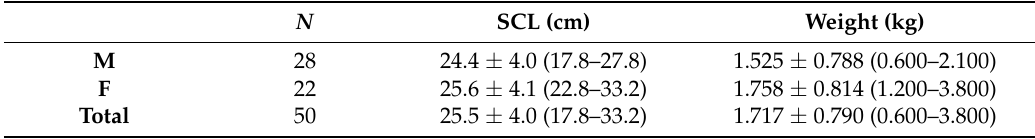
Table 2. Distribution of sampled Podocnemis unifilis individuals by sex and body size.